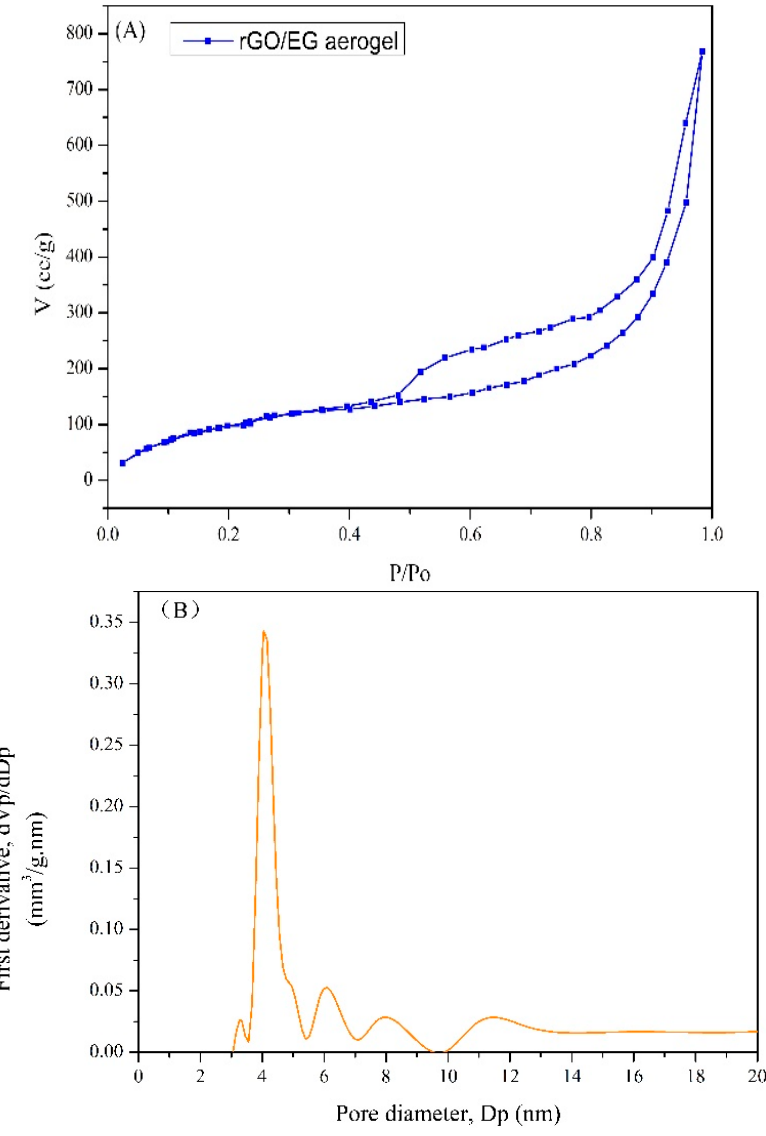
Figure 5. N 2 adsorption–desorption isotherm of rGO/EG aerogel ( A ), Barrett–Joyner–Halenda (BJH) pore size distribution of rGO/EG aerogel ( B ).